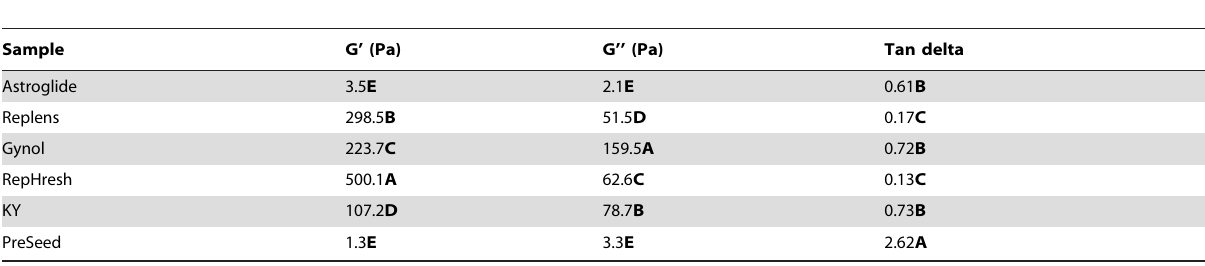
Table 3. Oscillatory measurements with 5% strain at 10 rad/s.